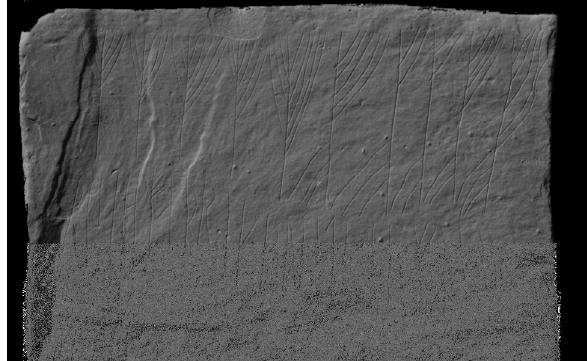
Figure 12. Meshed point cloud data from Viking runic inscription within Maeshowe chambered tomb © CDDV 2010.